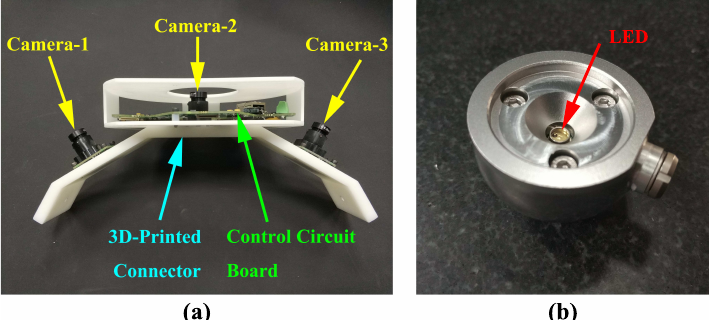
Figure 2. System hardware: ( a ) multi-camera rig and ( b ) active LED